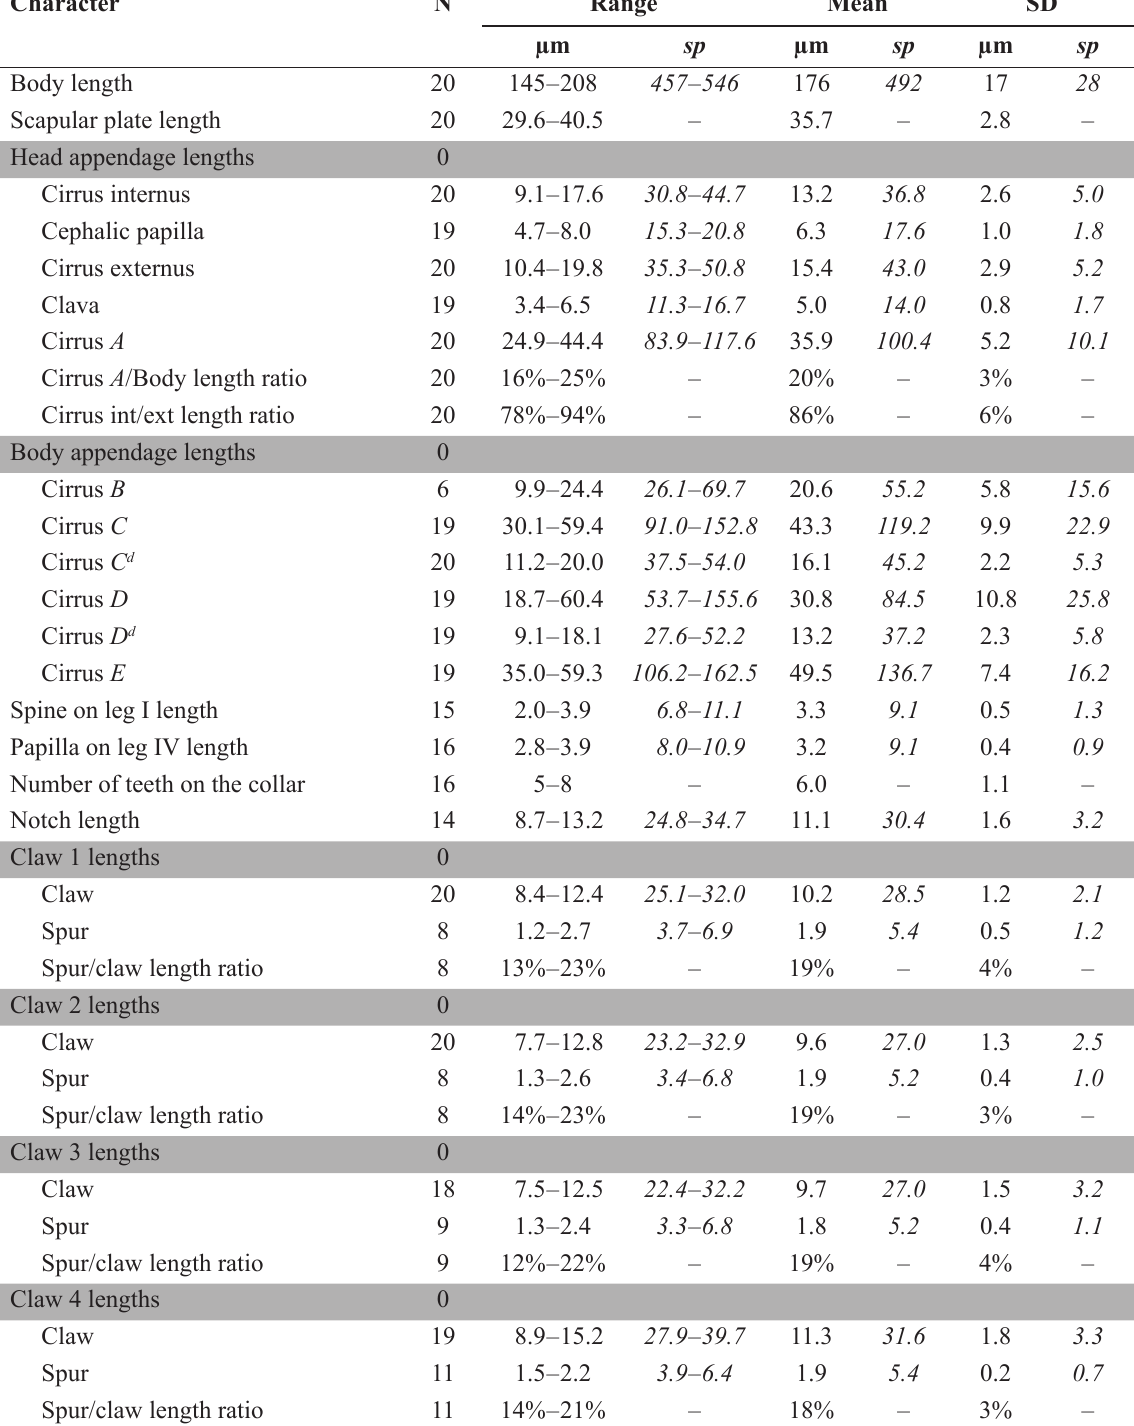
Table 3. Measurements (in µm) and sp values of selected morphological structures of juveniles from the neotype population of Echiniscus q. quadrispinosus Richters, 1902 mounted in Hoyer’s medium. Abbreviations: N = number of specimens/structures measured; RANGE = refers to the smallest and the largest structure among all measured specimens; SD = standard